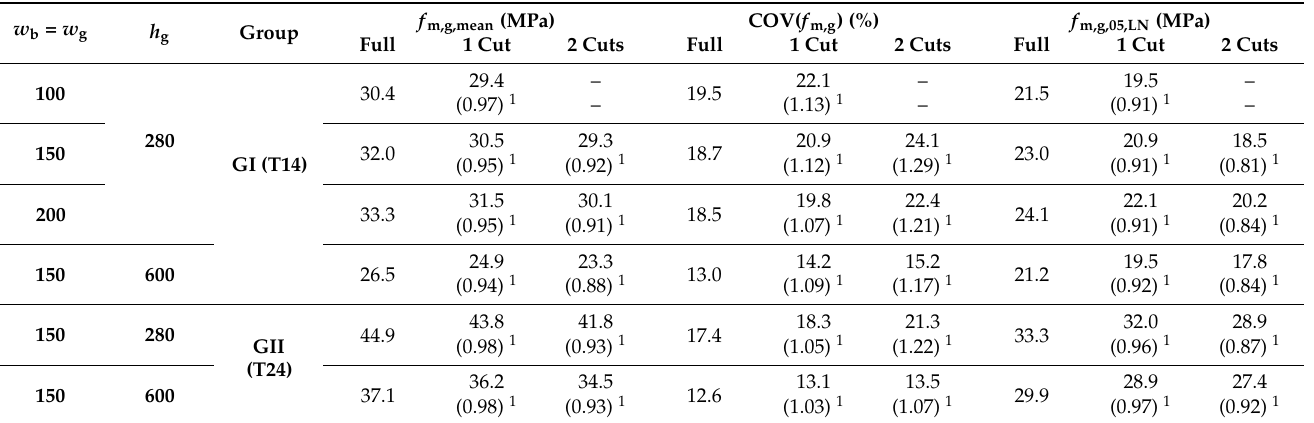
Table 12. Main statistics of the bending strength f m,g from 10 3 simulated glulam beams and resawn glulam {1 cut; 2cuts} for each parameter setting featuring various widths w g = {100; 150; 200} mm, depths h g = {280; 600} mm and base material GI (T14) and GII (T24).